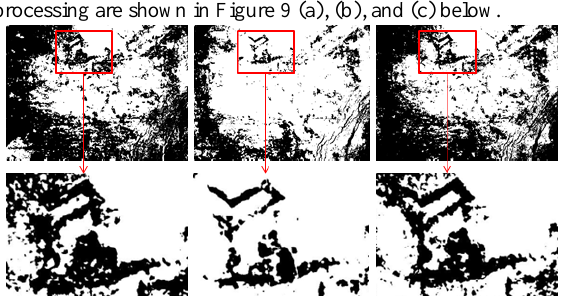
Figure 9. Image after density slice based on (a) the first principal component image after PCA ， (b) band math image using equation 1, (c) band math image using equation 2